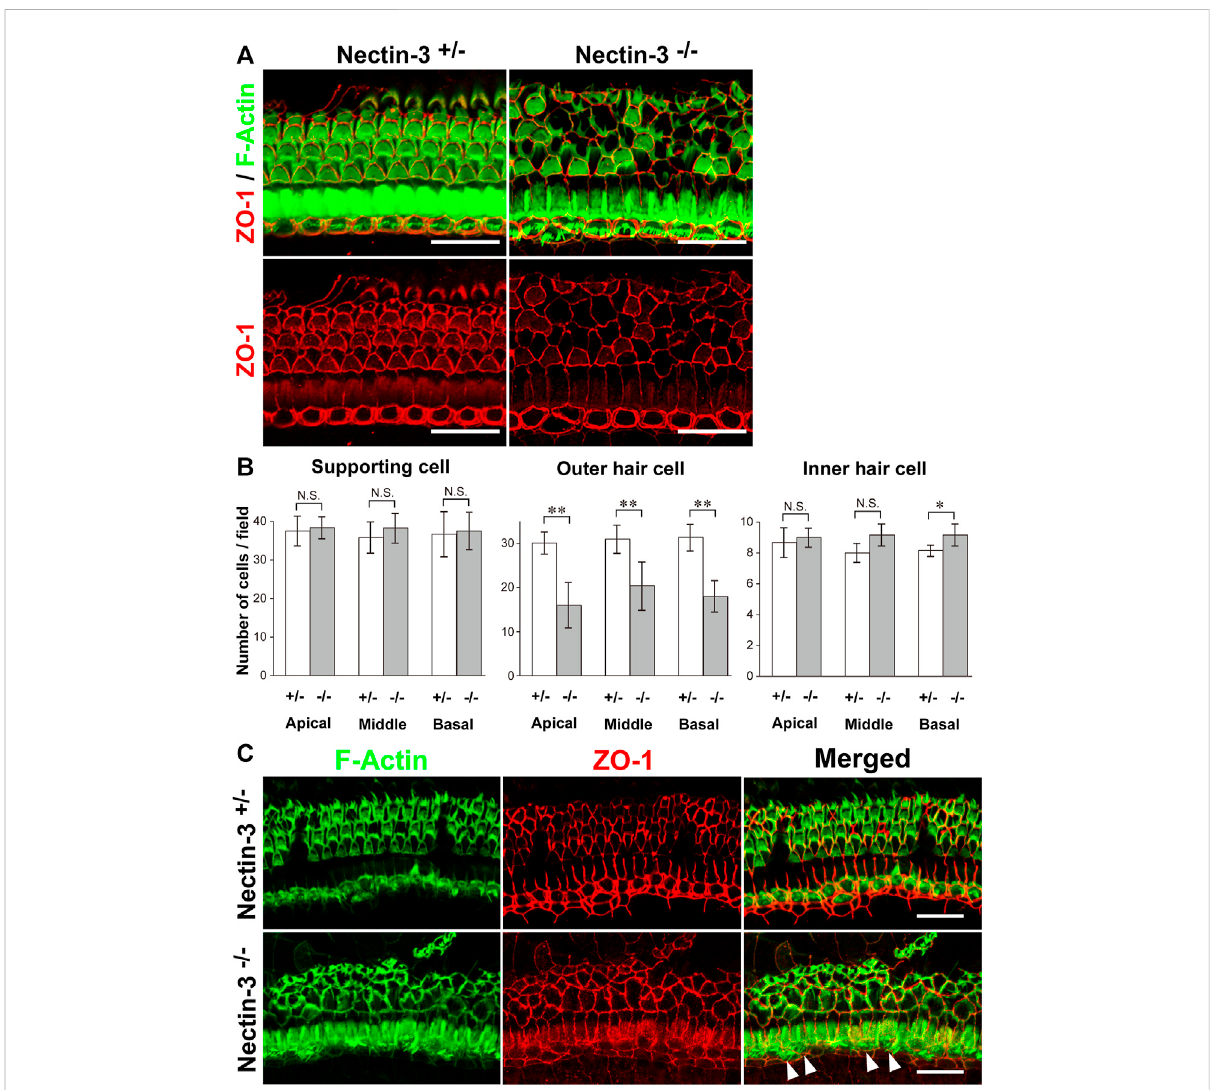
FIGURE 2 Morphology of the auditory epithelium from nectin-3 KO mice on P28 (A) Immuno fl uorescence signals for F-Actin (green) and ZO-1 (red) (upper panels) and ZO-1 (lower panels) in the middle turn of the auditory epithelium of nectin-3 +/ – and nectin-3 − / − on P28. Scale bars are 25 μ m. (B) Statistical analysis of cell number of supporting cell, outer hair cell, and inner hair cell in nectin-3 +/ – or nectin-3 − / − mice on P28. (Left) Numbers of supporting cells per photographic fi eld. (Middle) Numbers of outer hair cells per photographic fi eld. (Right) Numbers of inner hair cells per photographic fi eld. The results shown are the means ± SD. *, p < 0.05; **, p < 0.01, N.S., not signi fi cant. (C) Immuno fl uorescence signals for F-actin (green) and ZO-1 (red) in the middle turn of the auditory epithelium of nectin-3 +/ – (upper panels) or and nectin-3 − / − (lower panels) 1 year after birth. White arrowheads indicate the inner hair cells in nectin-3 − / − . Please note that the outer hair cells are lost in nectin-3 − / − ; however, the stereocilia of inner hair cells are still present. Scale bars are 30 μ